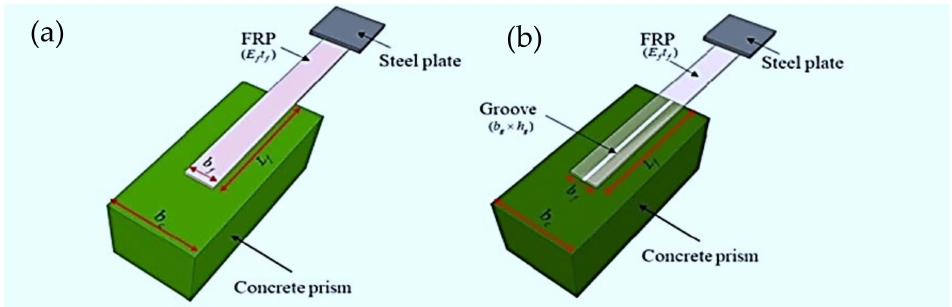
Figure 1. Single-lap shear test: ( a ) FRP externally bonded on concrete; ( b ) FRP externally bonded on the grooves of concrete (reprinted/adapted with permission from Su et al.